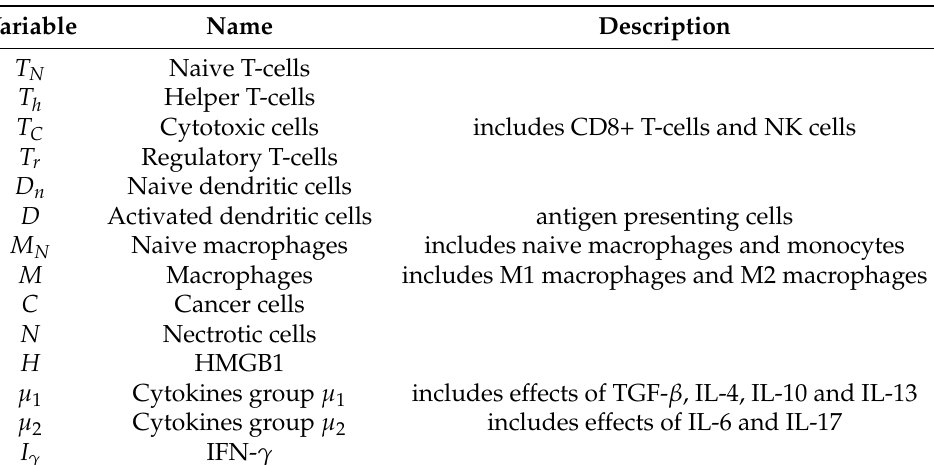
Table 1. Model Variables. Names and descriptions of the variables used in the